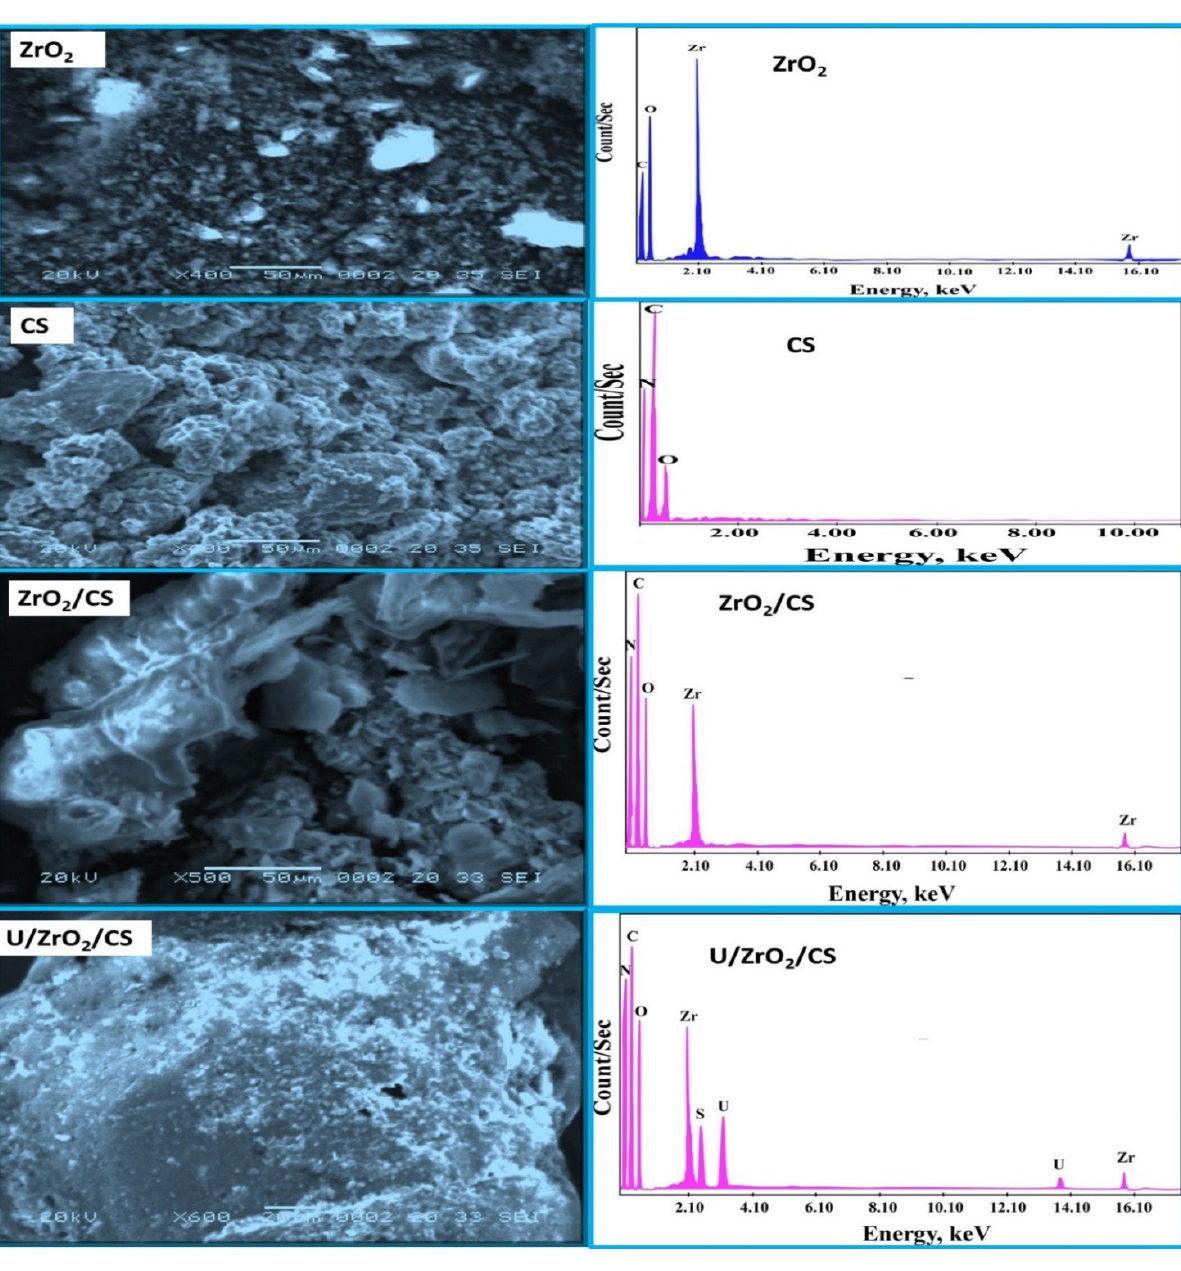
Figure 2. ZrO 2 , CS, ZrO 2 /CS, U/ZrO 2 /CS of SEM photographs, besides ZrO 2 , CS, ZrO 2 /CS, U/ZrO 2 /CS of EDX